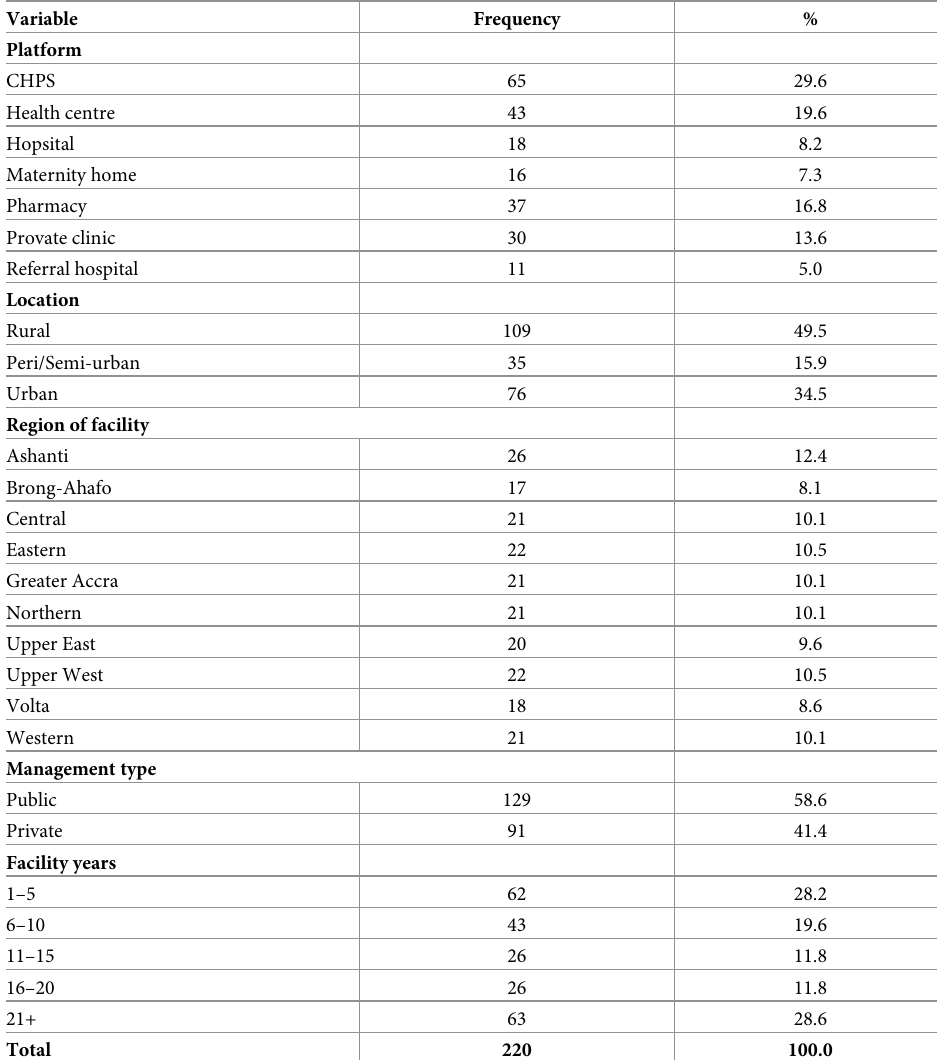
Table 1. Characteristics of health facities in